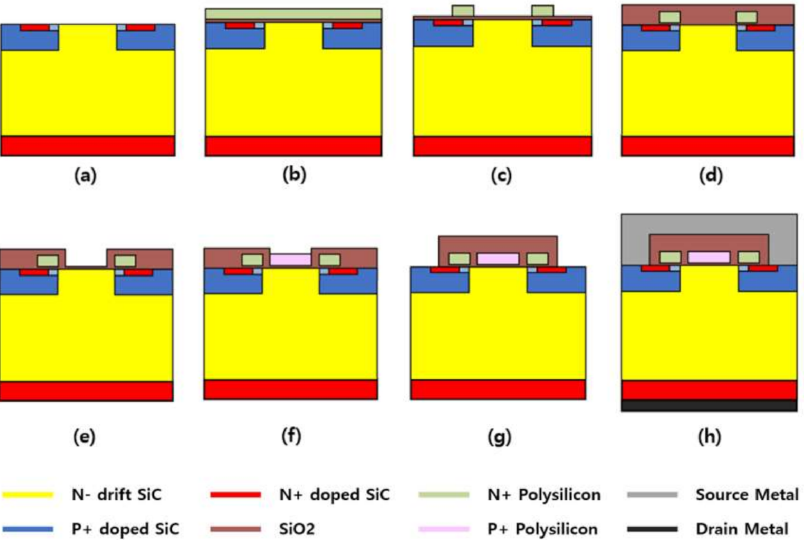
Figure 2. Proposed fabrication procedure of FPS-DMOSFET (floating p+ polysilicon DMOSFET). ( a ) form the p+ base and n+ source region; ( b ) thermal oxidation and n+ polysilicon deposition; ( c ) n+ polysilicon etching; ( d ) ILD (interlayer dielectric oxide) oxide deposition; ( e ) oxide etching and oxidation; ( f ) p+ polysilicon deposition and etch back; ( g ) ILD oxide deposition and etching; ( h ) form the source and drain